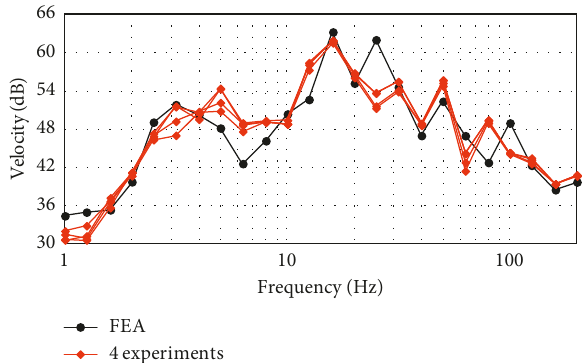
Figure 7: Comparison of the velocity dB between the finite element analysis and four experimental measurements at 5m from the rail